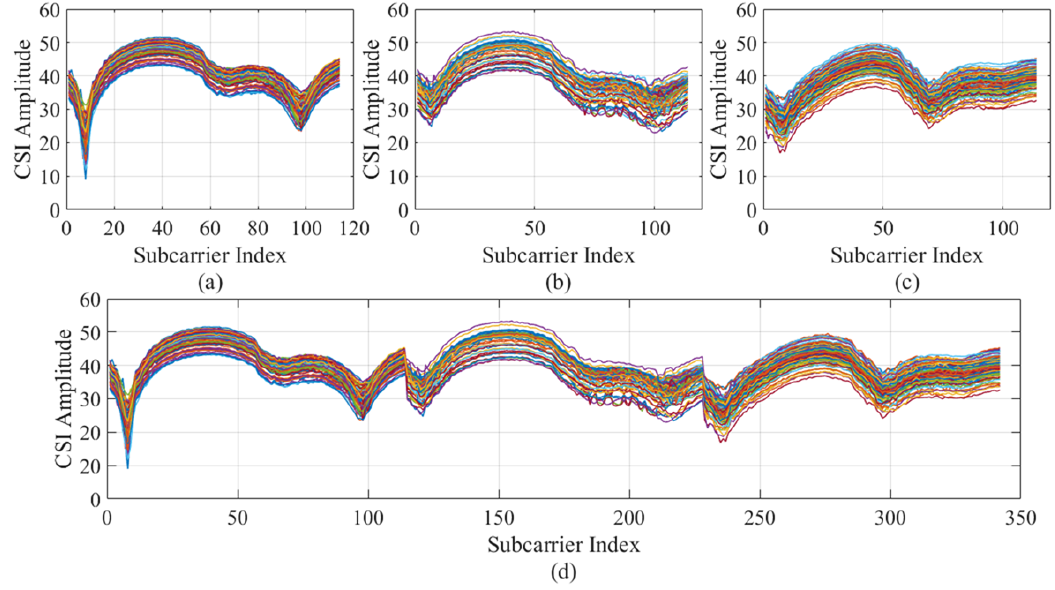
Figure 4. Link fusion process: ( a – c ) single link and ( d ) combined